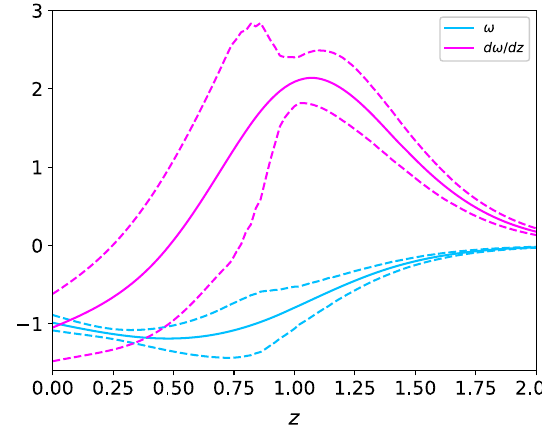
Fig. 5 The ω reconstruction using the joint analysis (CC+Pantheon) mean values and its functional form (left panel). The horizontal black dashed line represent the phantom divide. The right panel shows the